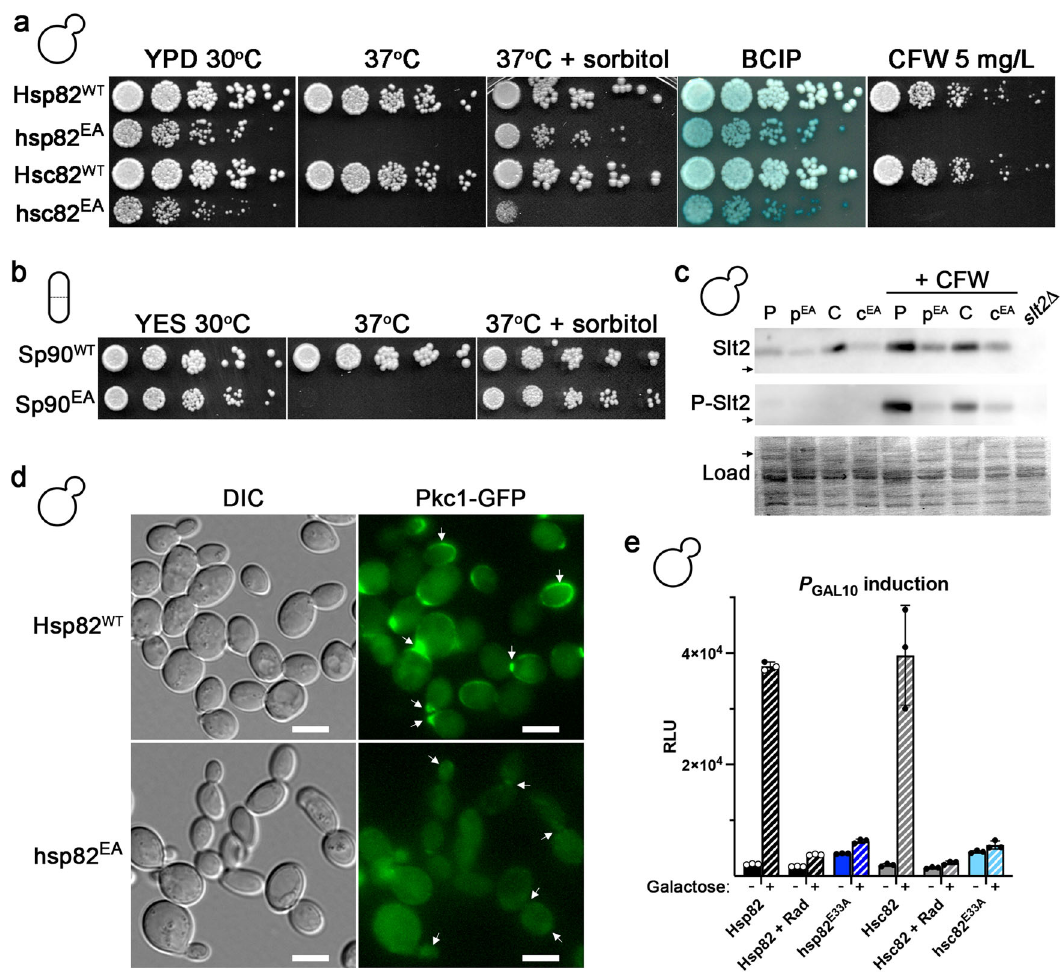
Fig. 3 | Cells expressing hydrolysis defective Hsp90 display conditional phe- notypes. a S. cerevisiae cells expressing the EA versions of Hsp82 or Hsc82 were osmo-remediated temperature sensitive (compare growth at 37 o C with and with- out sorbitol), had cell walls that leaked phosphatase at optimal temperatures (as denoted by bluer color of EA cells after BCIP overlay, see “ Methods ” ) and were sensitive to cell wall damaging agents such as calco fl uor white (CFW). b Sz. pombe expressing SpHsp90-EA was osmo-remediated temperature sensitive. c Representativewestern blots (of three independent experiments) showing levels of Slt2 protein (top) or phosphorylated Slt2 (P-Slt2, middle) in log-phase S. cerevi- siae cellsexpressingwildtypeHsp82(P)orHsc82(C)ortheE33Aversions(p EA ,c EA ),